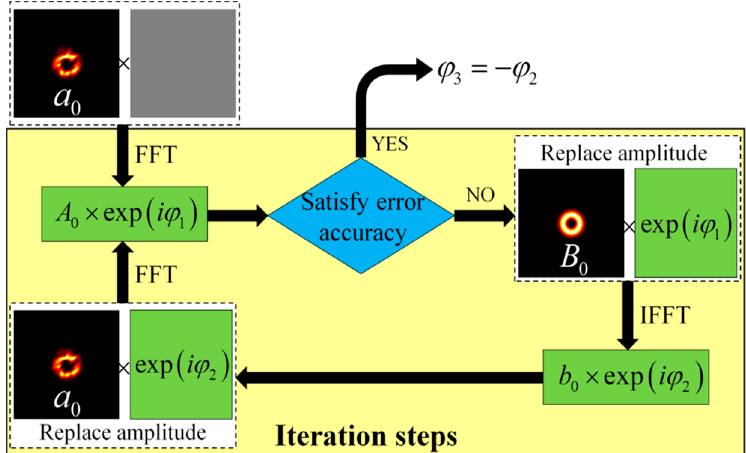
Figure 2. Iterative step of computing the compensation phase screen based on the Gerchberg-Saxton (GS) algorithm; (FFT: Fast Fourier Transform; IFFT: Inverse Fast Fourier Tranform.). (GS) algorithm; (FFT: Fast Fourier Transform; IFFT: Inverse Fast Fourier